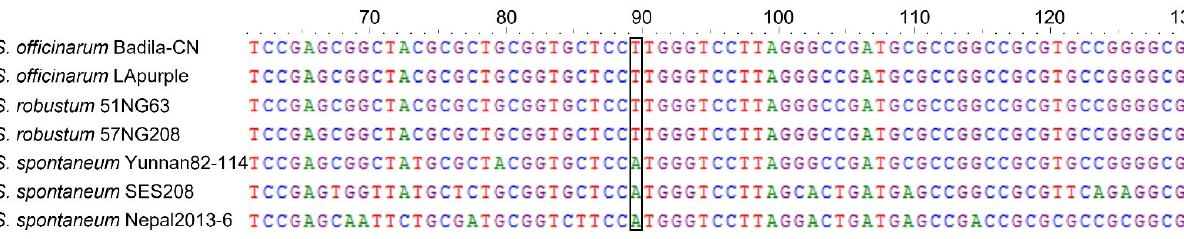
Figure 1. Alignment of partial internal transcribed spacers (ITS) sequences. Boxes indicate single nucleotide polymorphism (SNP) location within the genus Saccharum .